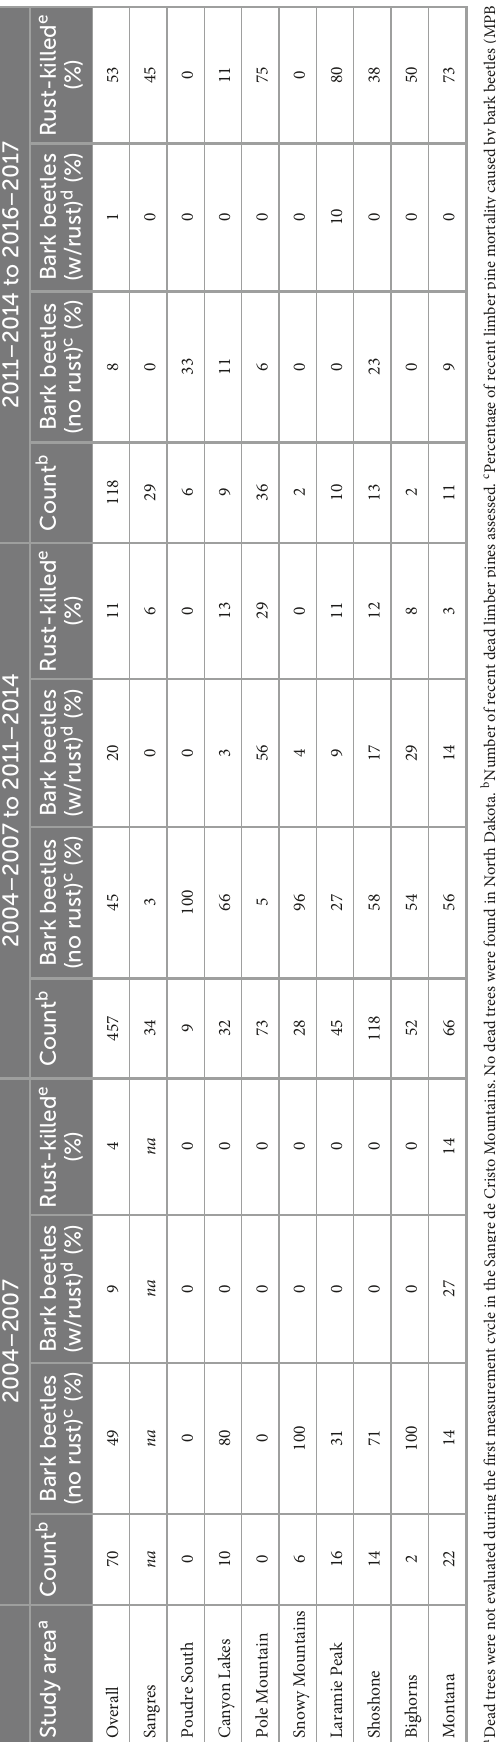
FIGURE2 Annual mortality rate of trees > 1.37 m tall from all causes (gray bars) and ingrowth recruitment rate (trees that grew taller than 1.37 m after the first measurement cycle; green bars) for limber pines overall and by study area from 2004–2007 to 2016–2017. Error bars indicate 95% confidence intervals.